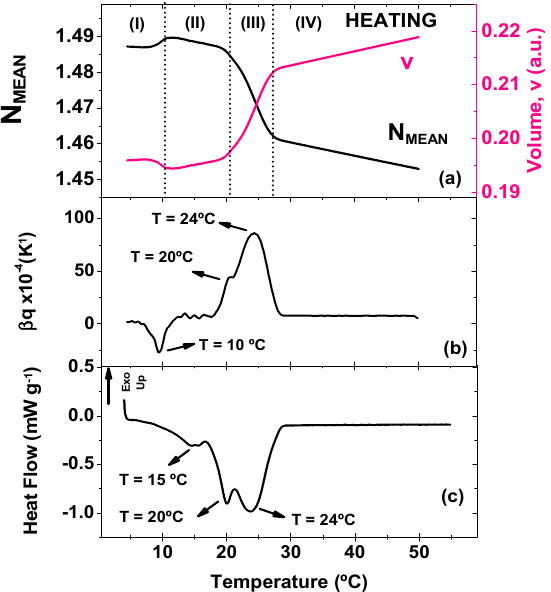
Figure 2. Comparison of the temperature dependence during heating at 0.5 K min − 1 of ( a ) N MEAN and Volume (a.u.) recorded via TMOR with temperature modulation of 0.5 K amplitude and 17 mHz modulation frequency. ( b ) The thermal volume expansion coefficient β q (K − 1 ) recorded via TMOR with temperature modulation of 0.5 K amplitude and 17 mHz modulation frequency, and ( c ) heat Flow (mW g − 1 ) recorded via DSC.